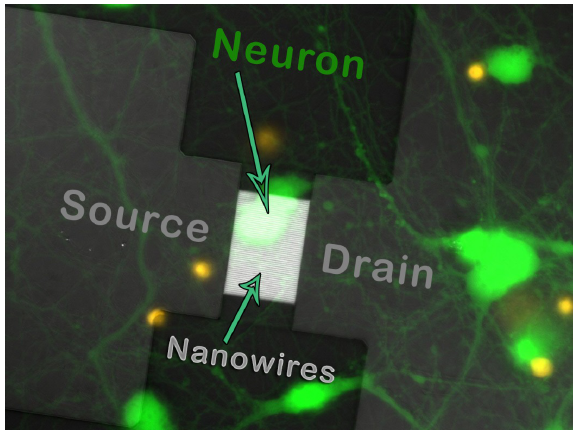
Figure 5: Double-gated Si NW FET sensor [6] (Gasparyan et al.,